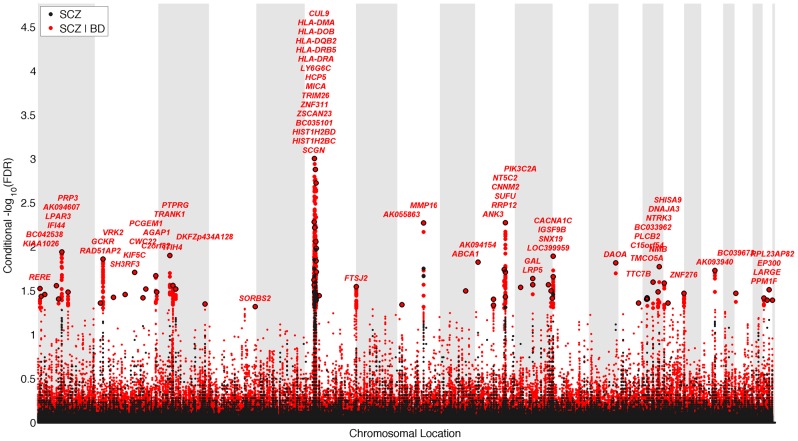
“Conditional Manhattan plot” of conditional −log10 (FDR) values for schizophrenia (SCZ) alone (black) and SCZ given bipolar disorder (BD; SCZ|BD, red).SNPs with conditional −log10 FDR>1.3 (i.e. FDR<0.05) are shown with large points. A black line around the large points indicates the most significant SNP in each LD block and this SNP was annotated with the closest gene, which is listed above the symbols in each locus. The figure shows the localization of significant loci. Details about the loci are provided in Table 1.